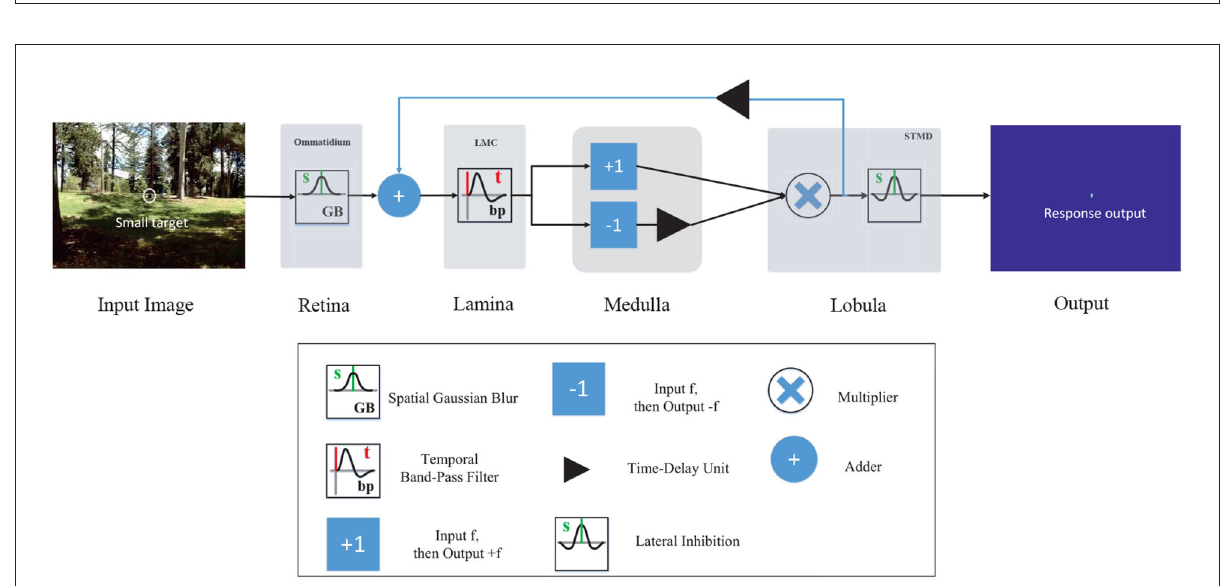
FIGURE2 Schematic illustration of the feedback STMD (FSTMD) model. Visual information perceived by the retina layer is further processed in several layers of neuropil including the lamina layer, medulla layer, and lobula layer. The feedback signal is propagated to the lamina layer via feedback pathway to mediate neural